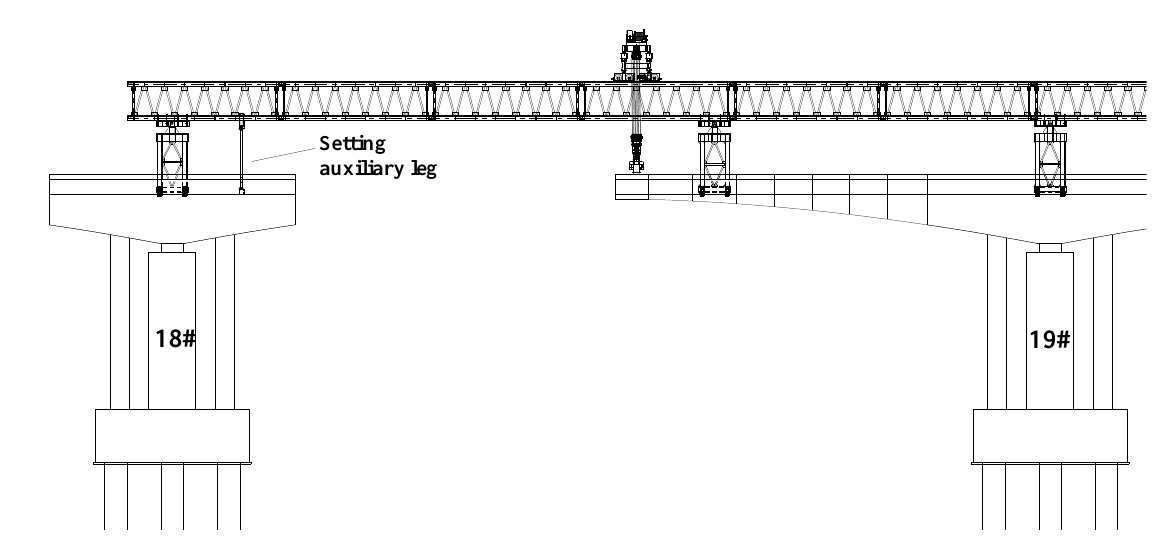
Figure 6. Auxiliary leg added when passing a hole.